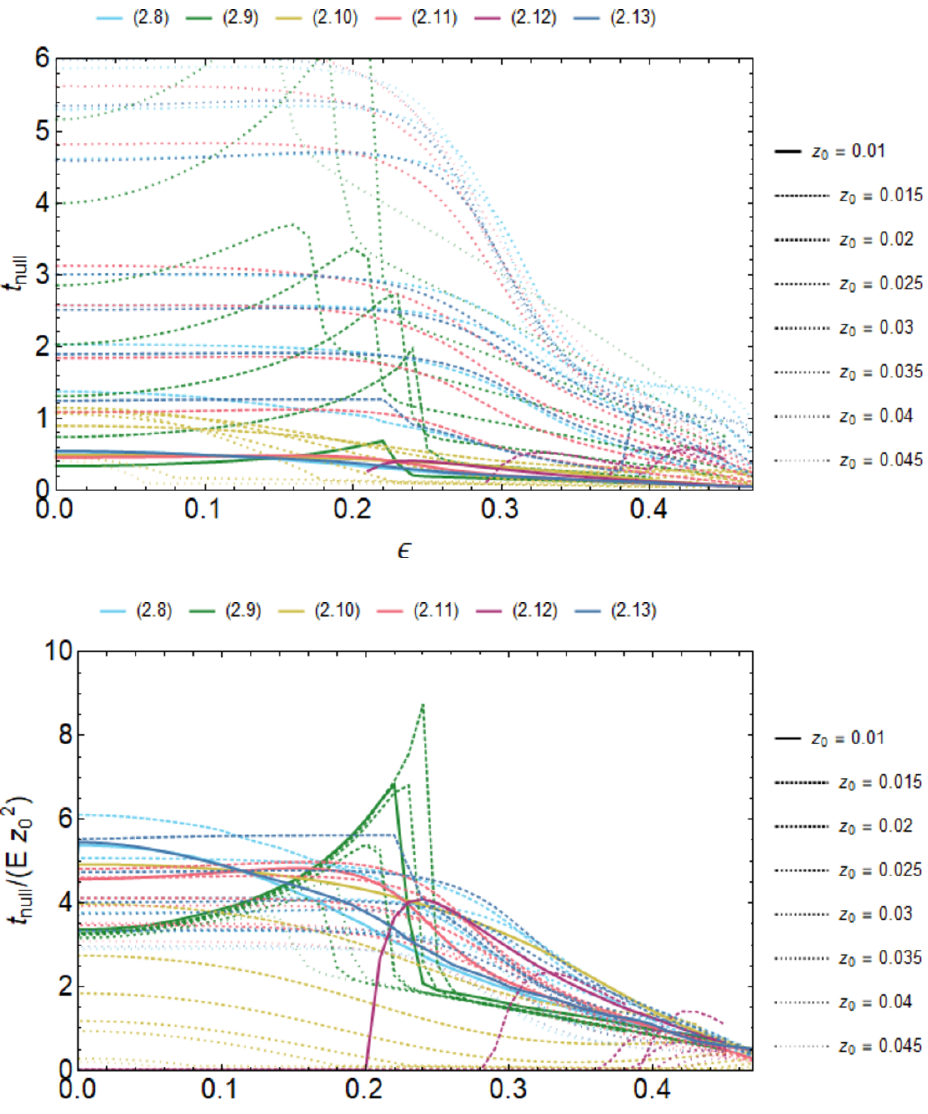
Figure 6 . For a point on the string above which a fraction (cid:15) of the string energy is found, we de(cid:12)ne the nulli(cid:12)cation time t null as the time that the angle found in (cid:12)gure 5 is within 10% of its (cid:12)nal value. In the upper panel we plot t null as a function of (cid:15) for the strings that we have analyzed. In the lower panel, we plot t null = ( Ez 2 ), and (cid:12)nd that the nulli(cid:12)cation time is roughly proportional 0 to z 2 for the strings whose endpoints had an initial downward angle of zero. Each color represents 0 one of the initial conditions from eqs. 2.8){(2.13 as shown at the top of the plot, and the degree of dashing indicates the value of z 0 used with that initial condition to produce the given curve. Those strings which we initialized with initial conditions (2.10) with their endpoints moving with a nonzero downward angle are closer to null from the beginning, meaning that it is no surprise that they nullify faster.